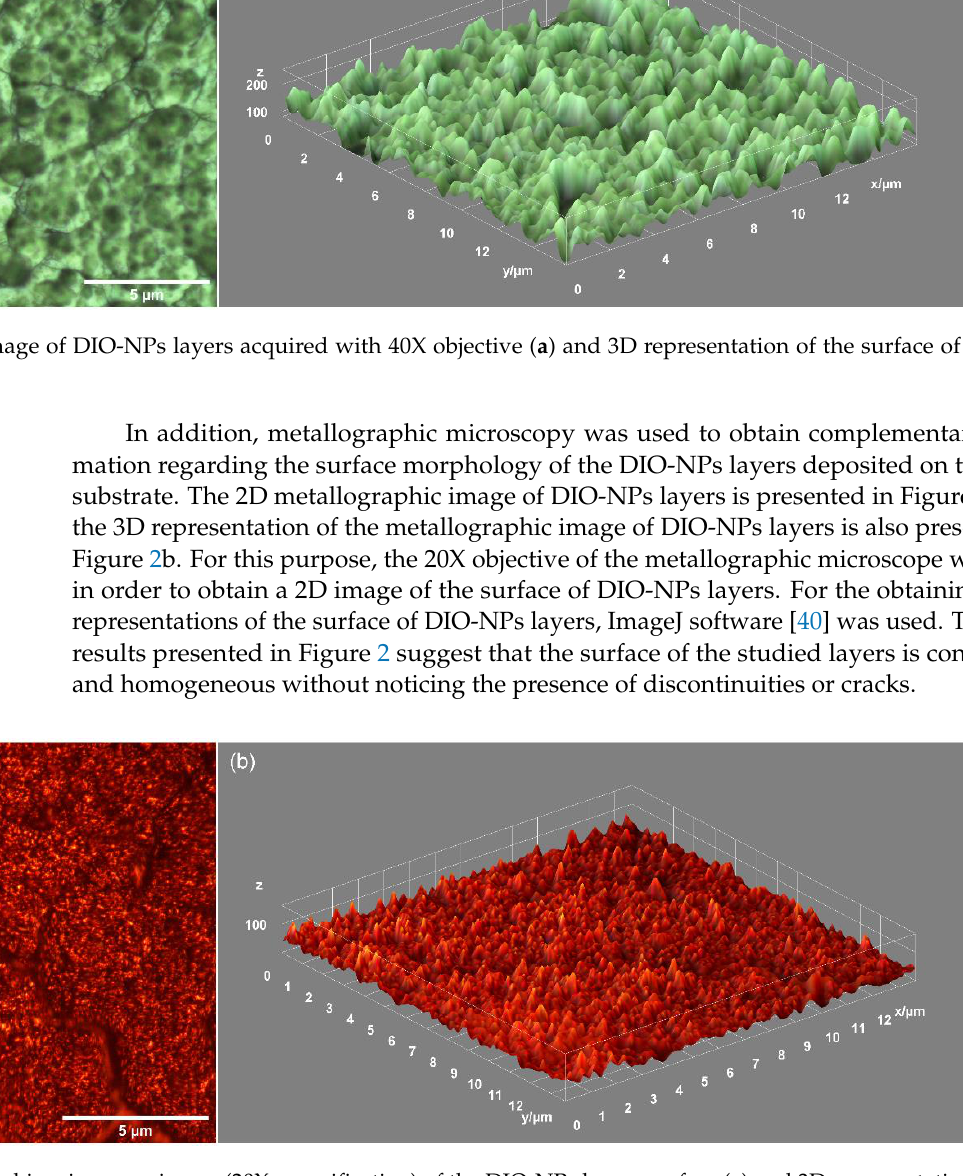
Figure 2. Metallographic microcopy image (20X magnification) of the DIO-NPs layers surface ( a ) and 3D representation of the surface of the DIO-NPs layers ( b ).